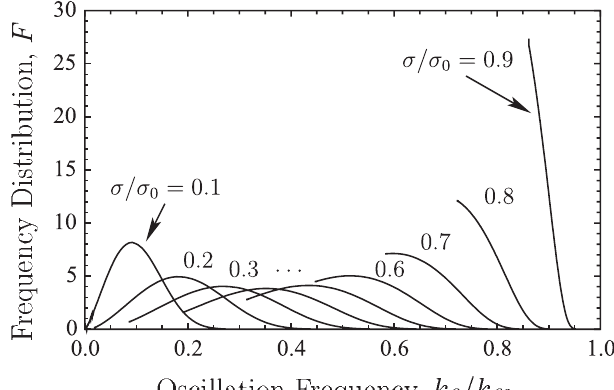
FIG. 6. Scaled particle oscillation wavelength (cid:10)=(cid:10) ð k (cid:10) Þ = ð 2 (cid:8) Þ (a) and oscillation frequency k (cid:1) 0 (b) versus dimensionless transformed Hamiltonian ~ H . Shown for rms-equivalent beam space-charge strength (cid:7)=(cid:7) 0 : 9 ; 0 : 8 ; 0 : 7 ; . . . ; 0 : 1 . Scaled equilibrium parameters correspond- are given in Table II. ing to (cid:7)=(cid:7) 0